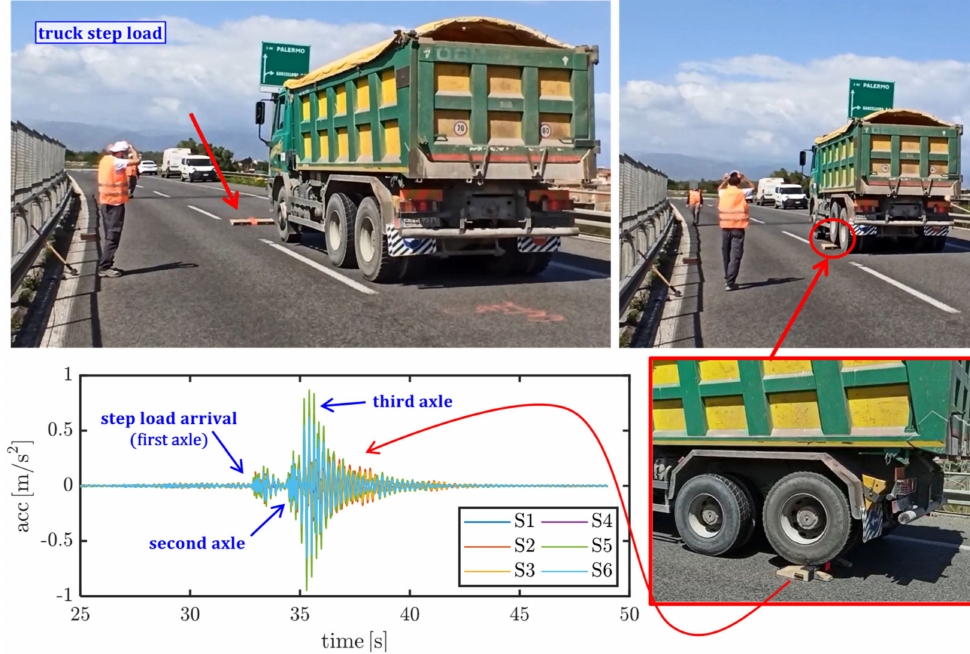
Figure 6. Dynamic excitation of the Longano viaduct realized with the transit of a three-axle 347 kN gross-weight truck on a 12 cm step and related filtered acceleration